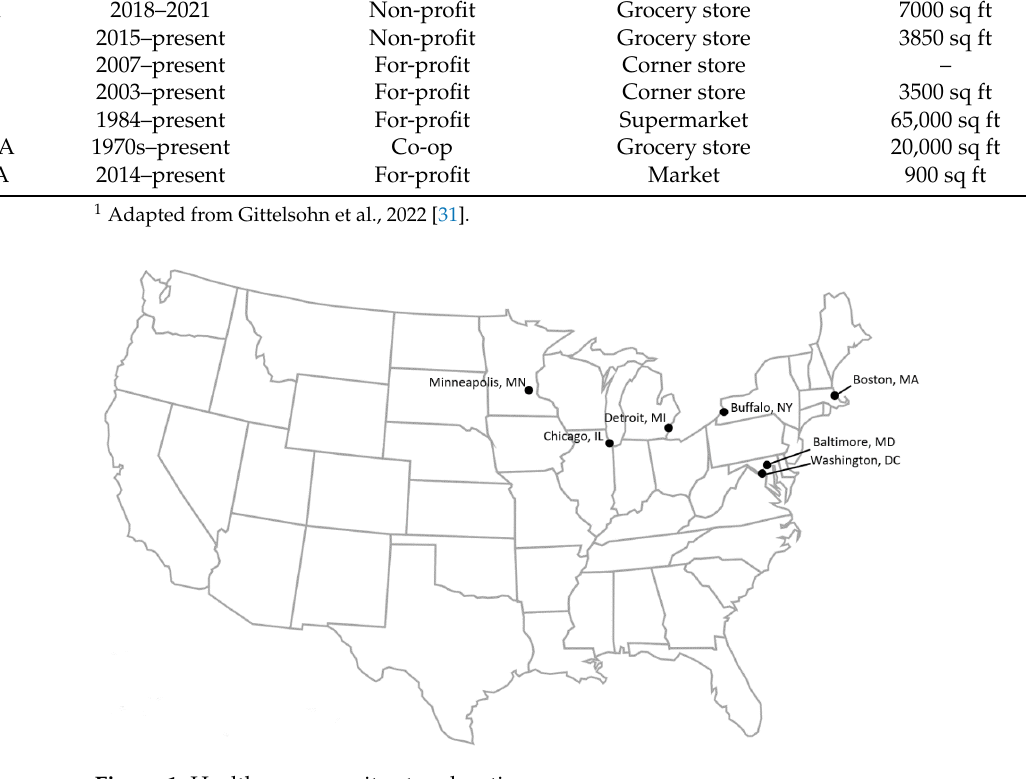
Figure 1. Healthy community store locations.